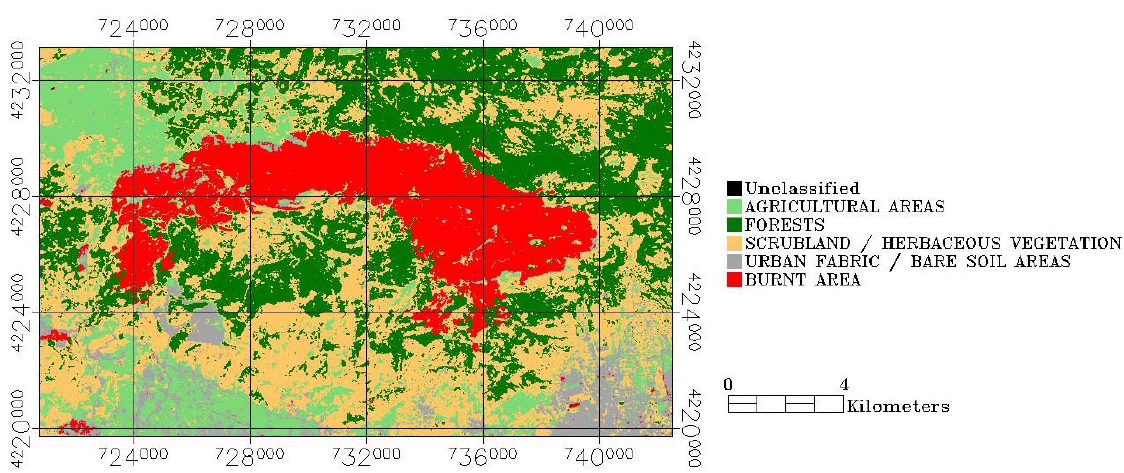
Figure 5. Cont . (b). SAM classification image for the study